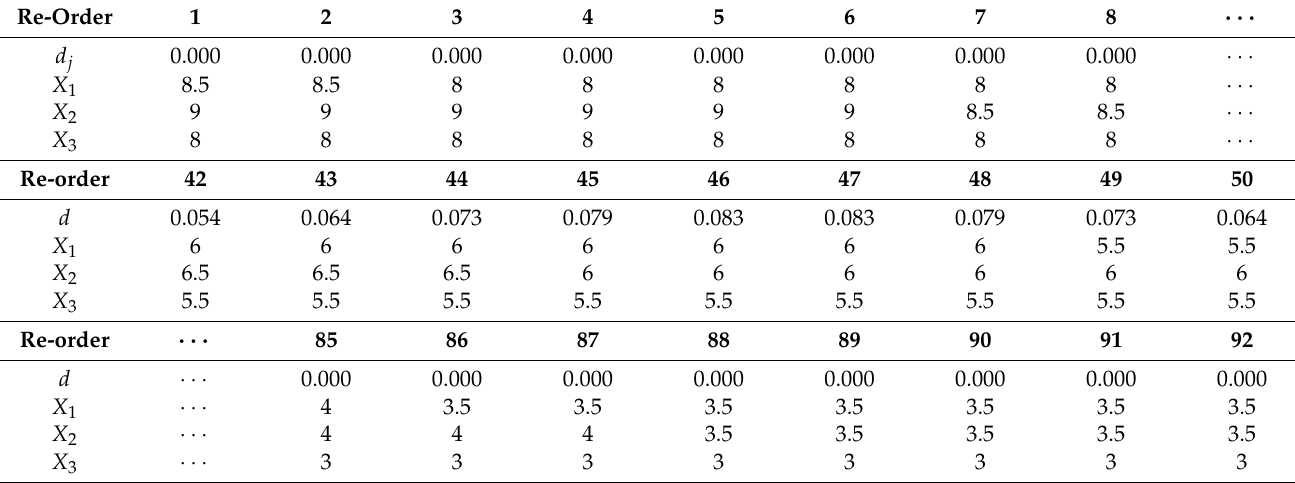
Table A5. Weight calculation of primary indexes.